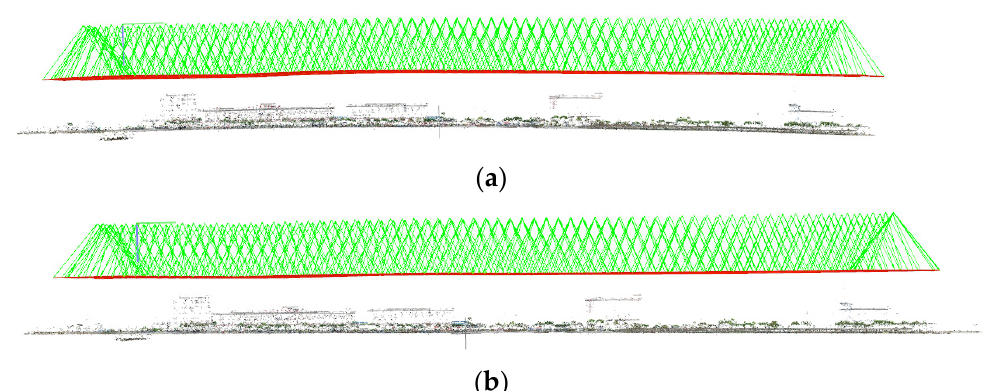
Figure 5. The reconstructed models with the proposed camera self-calibration strategy. ( a ) The result of image relative orientation, and ( b ) the result of image absolute orientation with the proposed strategy.